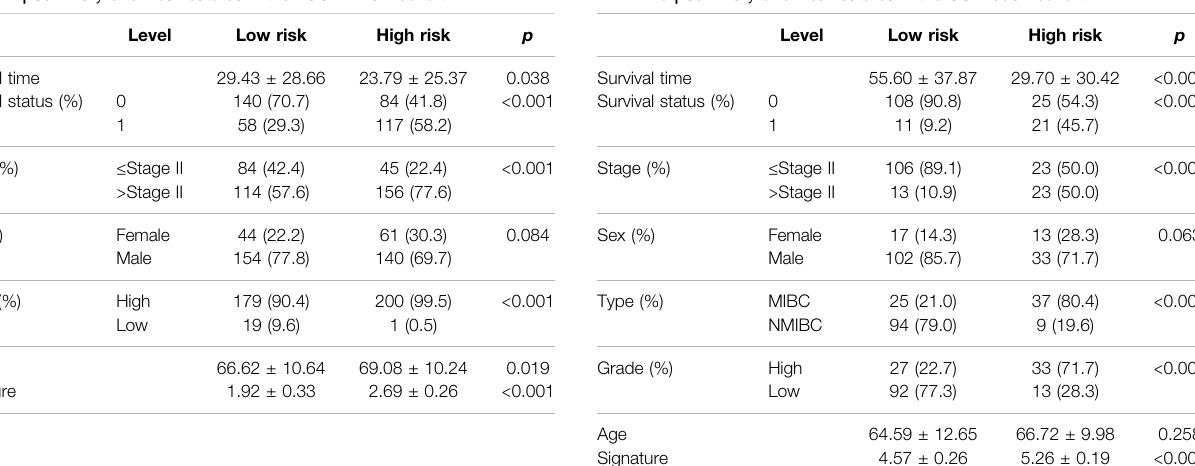
TABLE 2 | Summary of clinical features in the TCGA-BLCA cohort. TABLE 3 | Summary of clinical features in the GSE13507